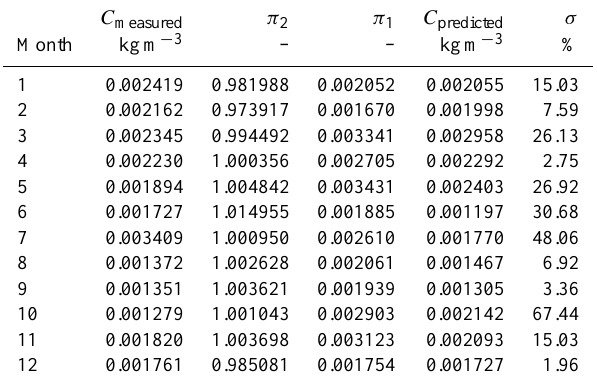
Table 2. Values of non-dimensional arguments, predicted concen- trations, uncertainty for nitrogen.